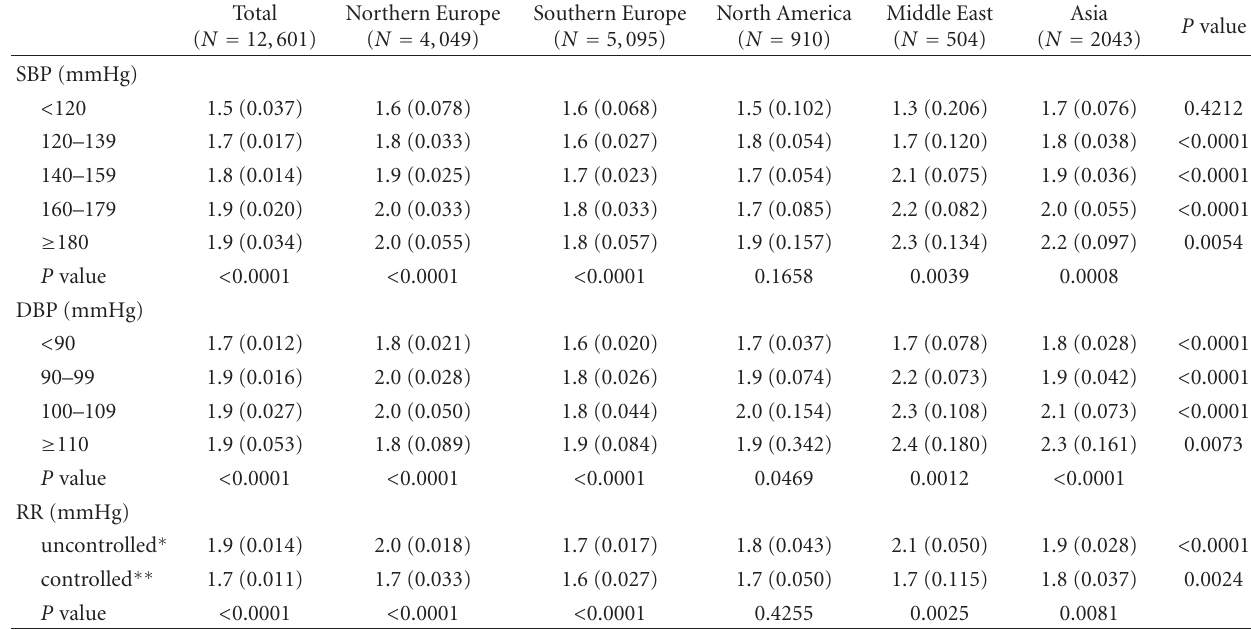
Table 8: Blood pressure and triglycerides (mmol/L ± SD, adjusted for age, gender, and diabetes).